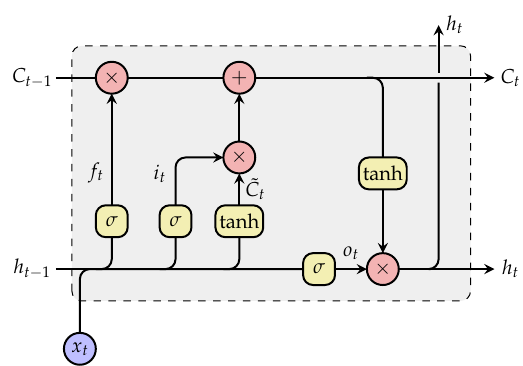
Figure 3. Attention Network.